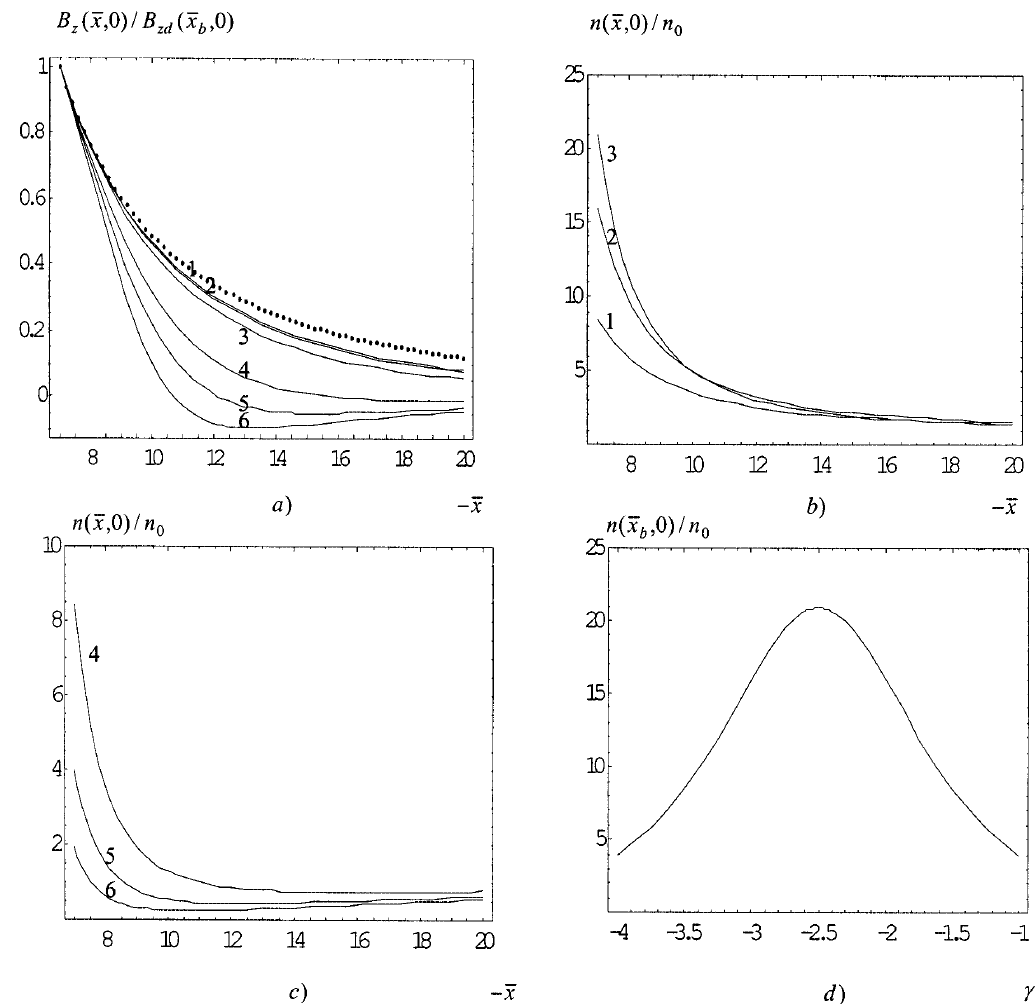
Fig. 1. (a) Variation of the dimensionless field component B z (x, 0 )/B zd (x b , 0 ) along the sheet versus the dimensionless distance x . For comparison, the variation B zd (x, 0 )/B zd (x b , 0 ) is shown by a dotted line. (b) , (c) Variation of the dimensionless plasma density (current density) n(x, 0 )/n 0 = j(x, 0 )/j 0 . (d) The plasma density n(x b , 0 )/n 0 under x = x b = − 7 as a function γ . Numbers at curves correspond: γ 1 = − 1 . 5, γ 2 = − 2 . 0, γ 3 = − 2 . 5, γ 4 = − 3 . 5, γ 5 = − 4, γ 6 = − 4 .